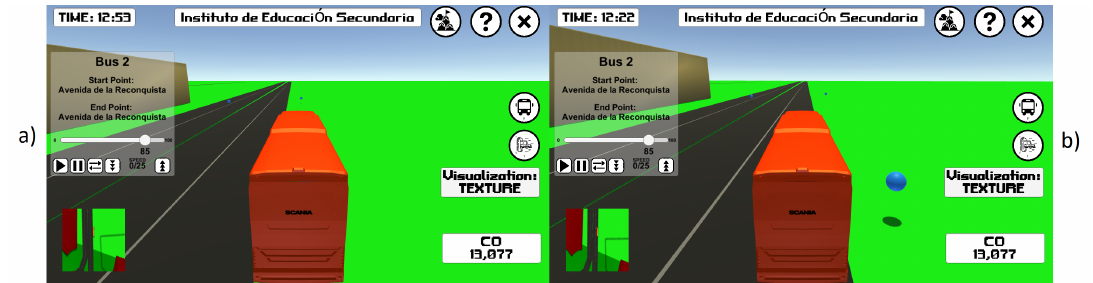
Figure 3. Driving algorithm correcting animated bus’ motion so as to ensure that it stays on the road. The drift away from the road is a consequence of noise in the GPS trace and it was exaggerated for the sake of clarification by under-sampling the trace. The magnitude of the drift is higher or lower depending on whether the driving algorithm is activated ( a ) or not ( b ). The blue sphere represents the key-point along the under-sampled GPS trace being currently tracked by the bus. The driving algorithm allows the bus to relax the goal of accurately tracking these key-points so as to ensure that it stays on the